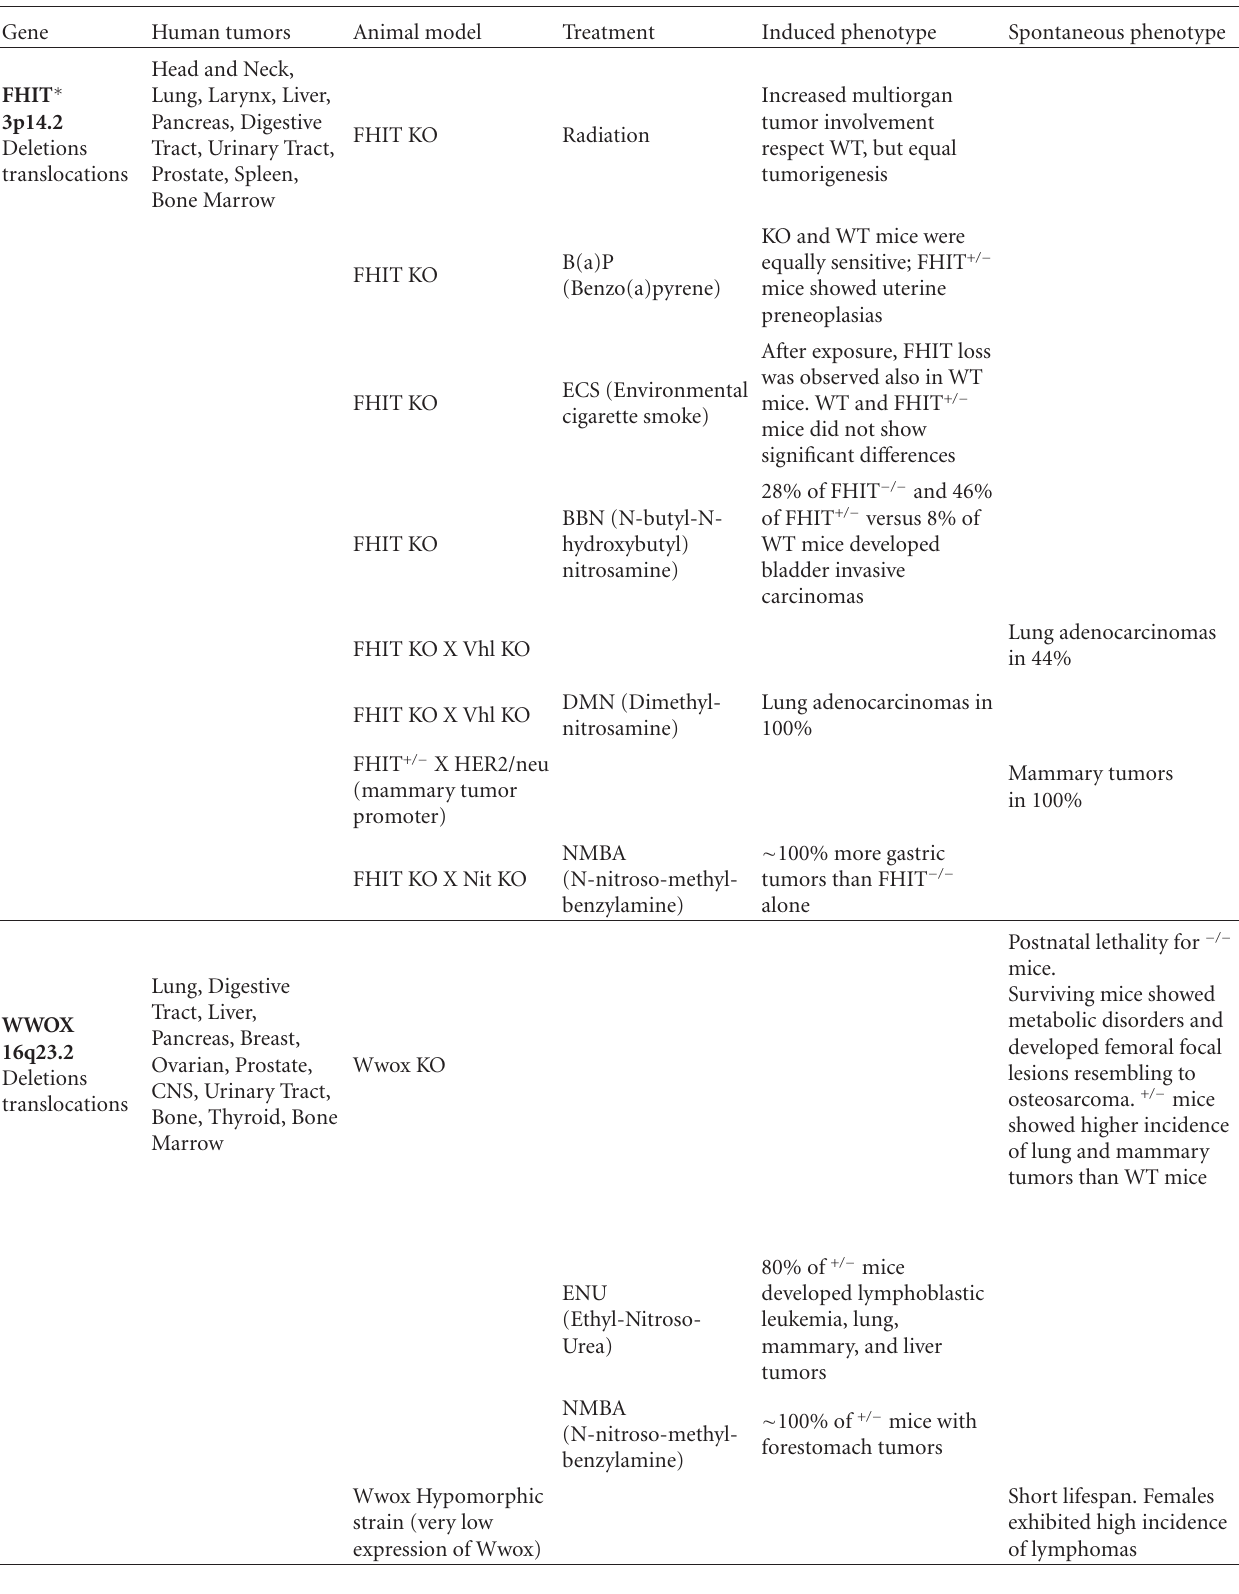
Table 1: Synopsis of CFS tumor suppressor genes and their mouse models of